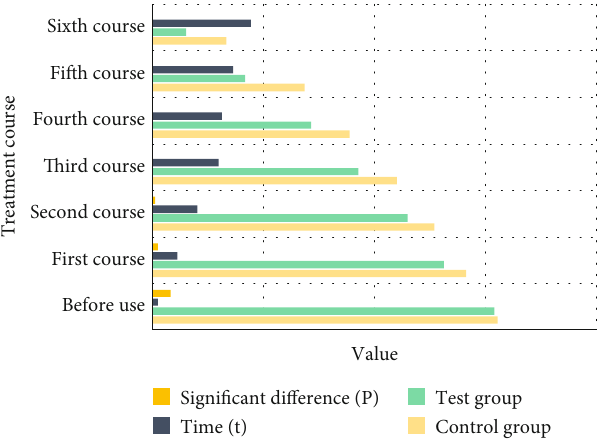
Figure 3: Comparison of anxiety between the two groups of patients before and after